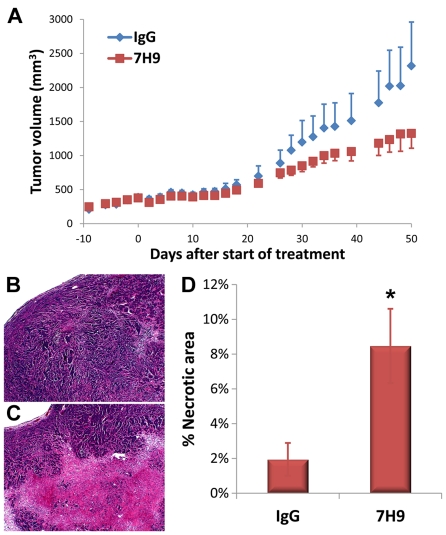
7H9 inhibits development of breast tumor xenografts.(A) Volumes of subcutaneous MCF7 tumors in nude mice were determined by caliper measurement. (B-C) Photomicrographs showing H&E stained tumors from IgG control (B) and 7H9-treated (C) mice. (D) Volumes of “necrotic” regions were determined by measuring their cross-sectional areas relative to total area of section. *p<0.05.